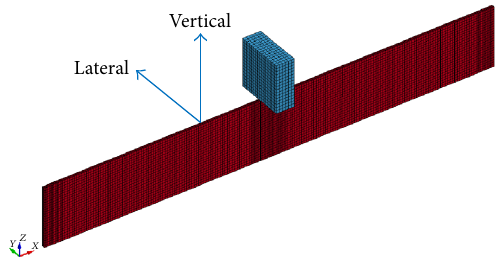
Figure 15: Finite element